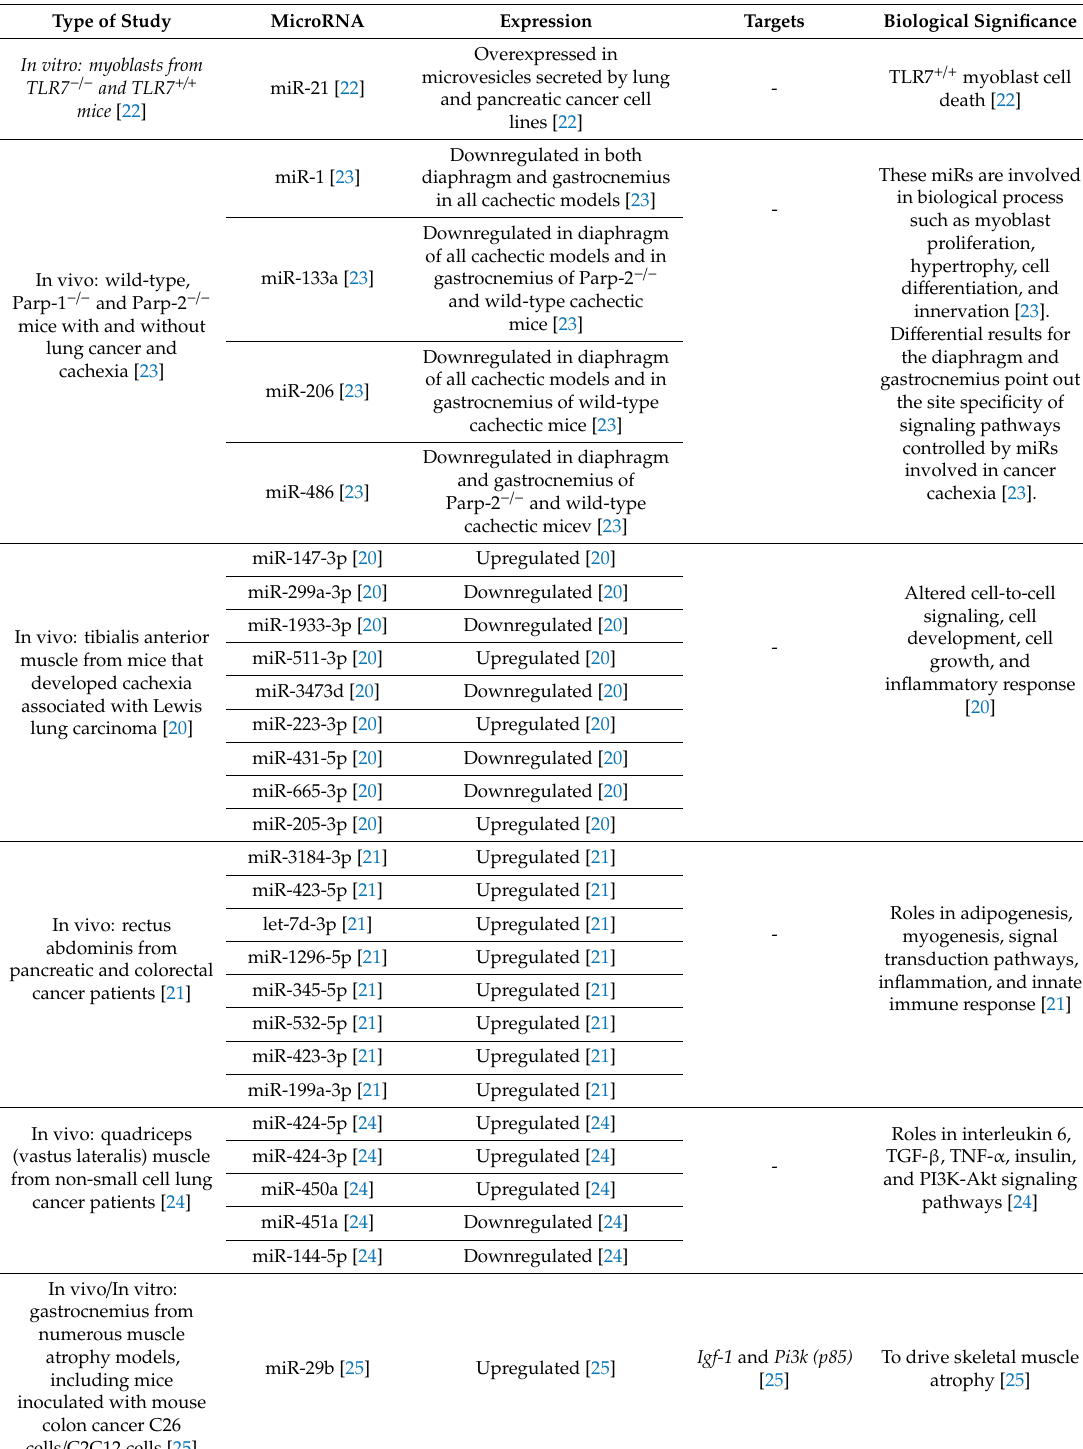
Table 1. MicroRNAs (miRs) involved in muscle